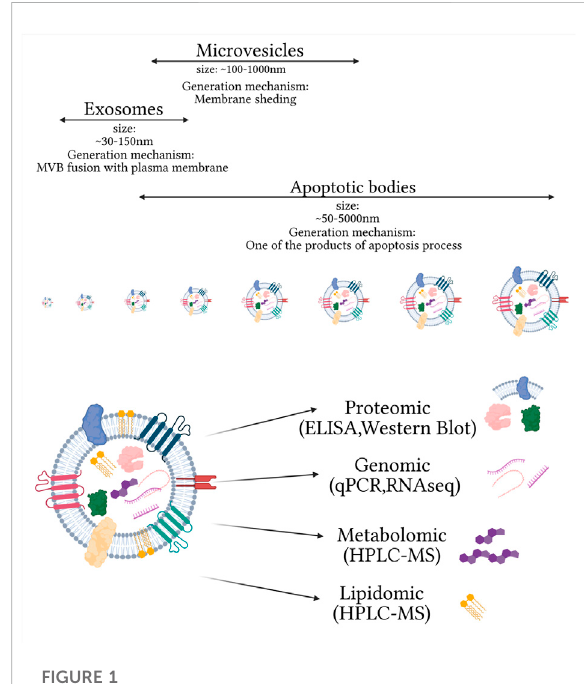
FIGURE 1 Main extracellular vesicle subtypes and complexity of small extracellular vesicle composition, on omics used for their analysis. Created with